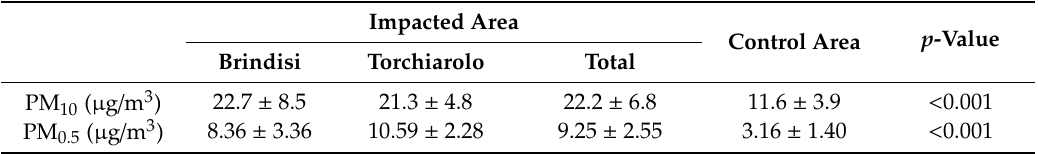
Table 5. Data on particulate matter (PM) fractions measured in the samples from the two areas. Data are reported as mean value of four samples in the impacted area and five samples in control area.